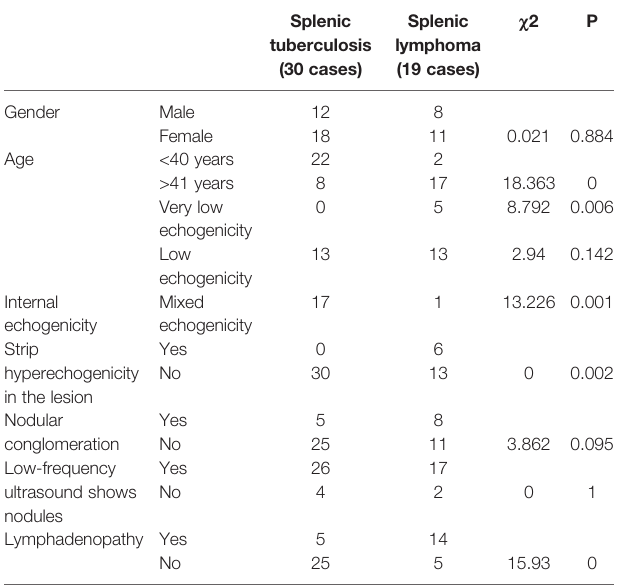
TABLE 1 | Comparison of splenic tuberculosis and splenic lymphoma by 2D and color Doppler